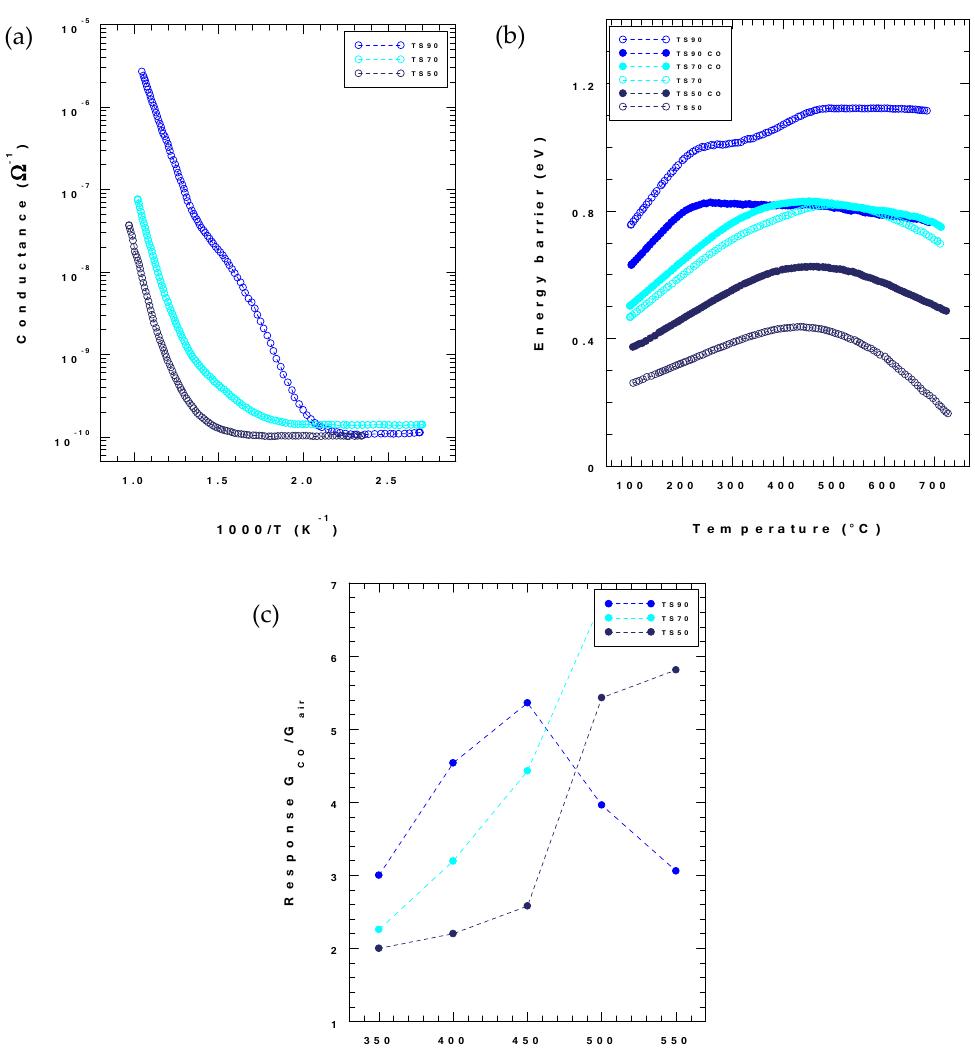
Figure 5. Conductance vs. temperature in dry air ( a ), comparison between the energy barrier dependence on temperature in dry air and in a mixture of dry air and CO (100 ppm) ( b ), responses to 50 ppm of CO reported as G CO /G air obtained at different temperatures ( c ) for the Ti-Sn mixed oxides.